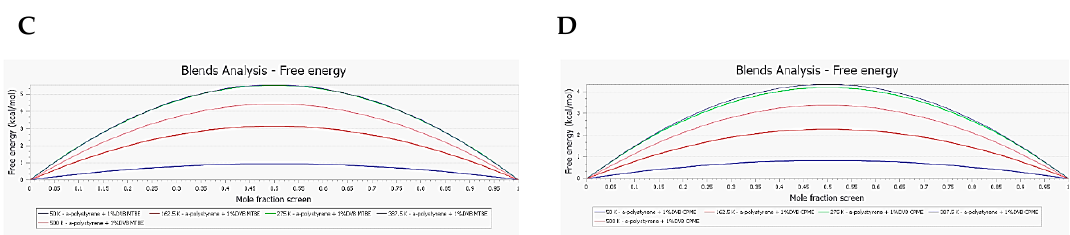
Figure 7. Chart displaying free energy dependence on temperature (50–500 K): ( A ) DEE; ( B ) 2-MeTHF; ( C ) MTBE; and, ( D ) CPME. Swelling free energy in Kcal/mol at 280 K and 0.5 mole fraction: DEE 7.4 > 2-MeTHF 6.5 > MTBE 5.6 > CPME 4.2.